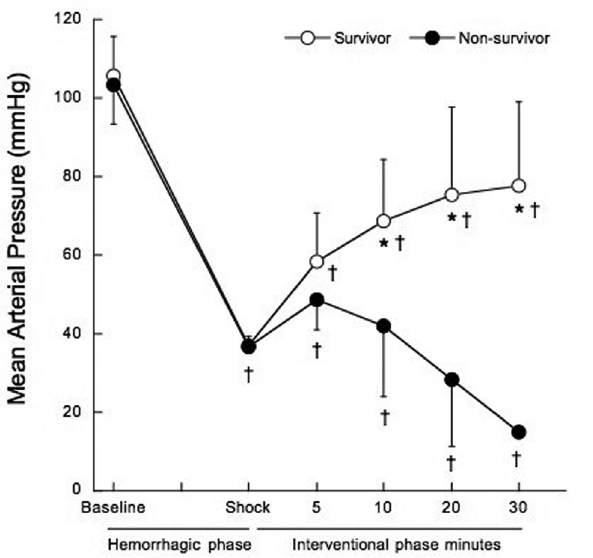
Figure 3 - Mean serum potassium before treatment at hemorrhagic phase (baseline and shock ), and after treatment at the end of the interventional phase, in survivors (open circles) and non-survivors (filled circles). † p <0.001 when compared to baseline. * p <0.05 when compared to